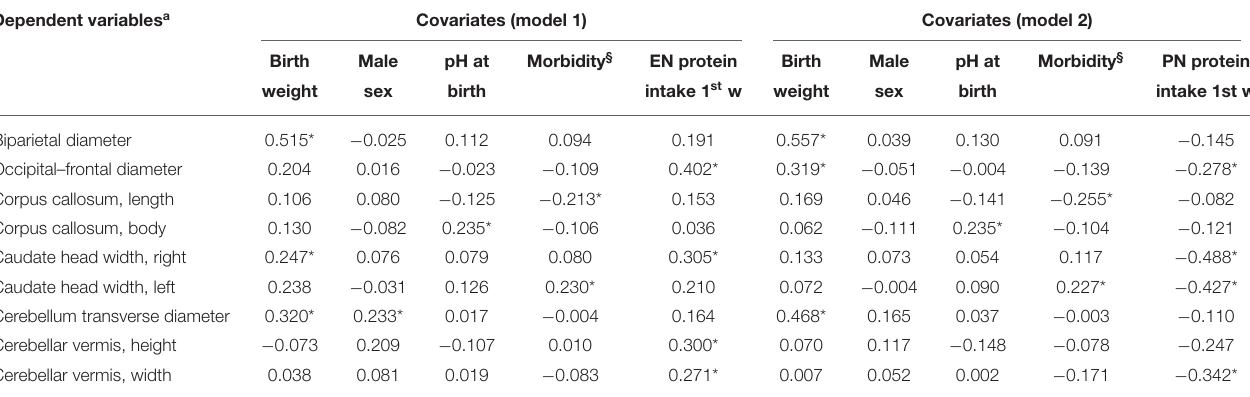
TABLE 3 | Multivariate analysis of covariate influencing cerebral measures at 28 days of life in preterm newborns. Dependent variables